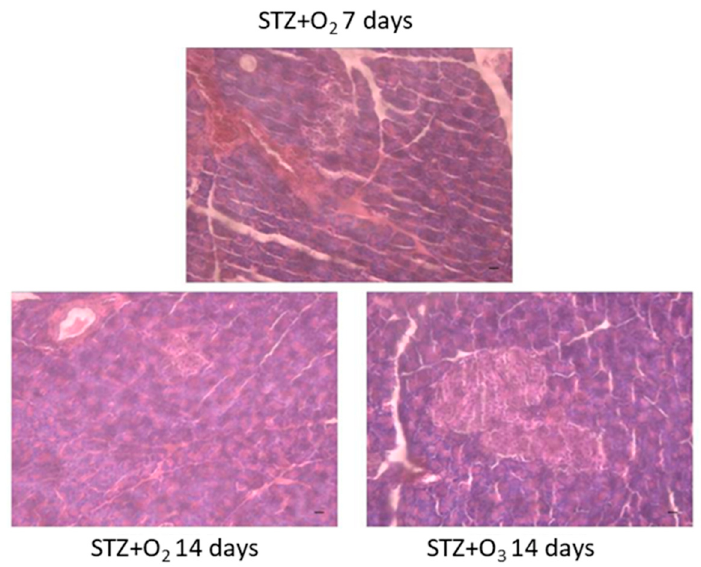
Figure 3. Hematoxylin and eosin (HE) staining. HE of pancreatic tissue from STZ rats treated with O 2 seven days post STZ and 14 days post STZ. Pancreatic tissue damage was present at seven days and maximal at 14 days. Ozone treatment showed restoration of normal cellular population size of islets of Langerhans and absence of islet damage. STZ + O 2 = oxygen-treated STZ rats; STZ + O 3 = oxygen/ozone-treated STZ rats. Scale bar = 50 µm